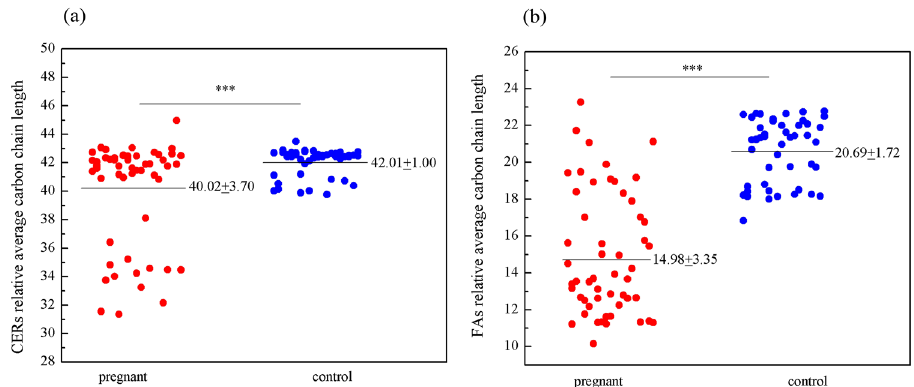
Figure 4. ( a ) Ceramide (Cers) relative average carbon chain length in patients with pregnant compared with control. ( b ) Fatty acyls (FAs) relative average carbon chain length in patients with pregnant compared with